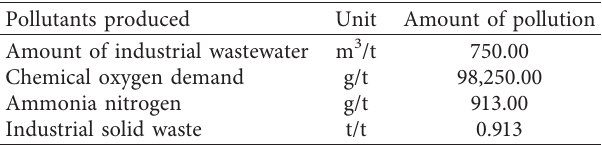
Table 3: The amount of pollution caused by weathered crust elution-deposited rare earth ore from the production units